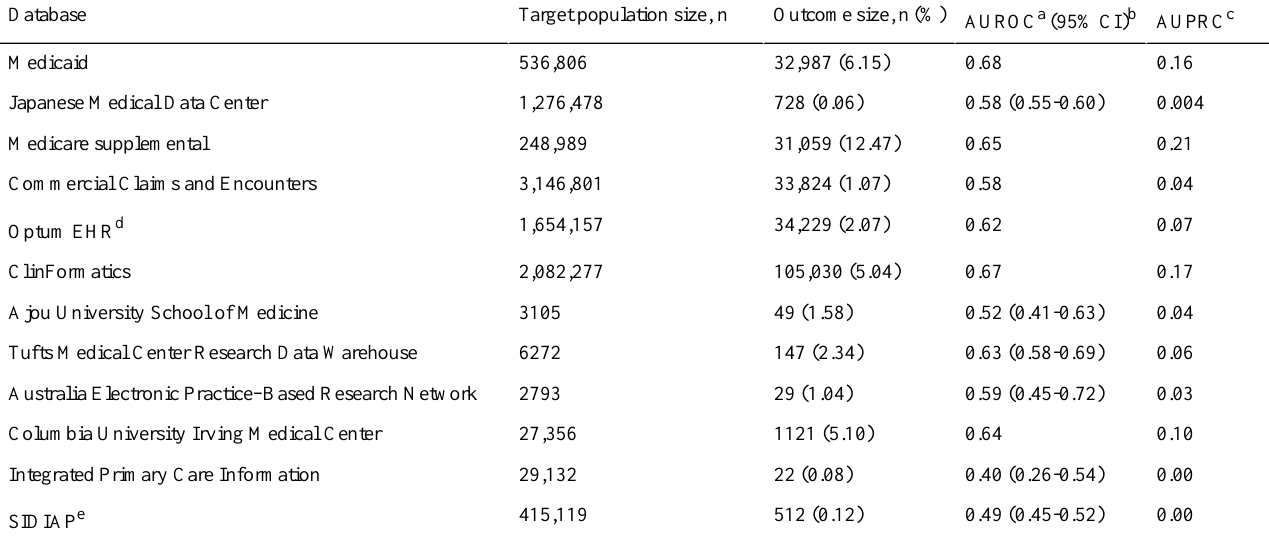
Table 3. External validation of the COVID-19 vulnerability index model on influenza patient data (non–COVID-19